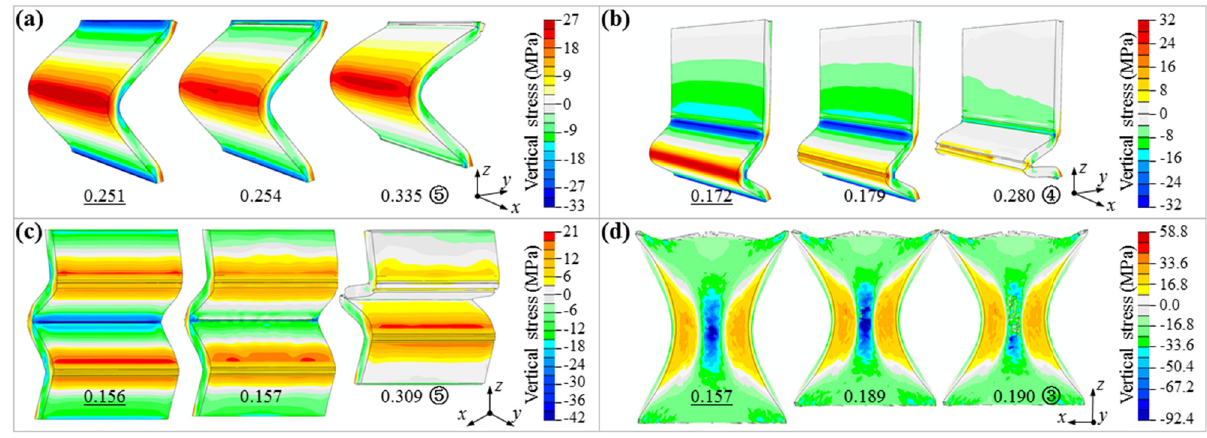
Figure 12: Vertical stress fi eld of spoke No. 1 of ( a ) Tweel; ( b ) Tweel - 2; ( c ) honeycomb; and ( d ) saddle tire samples. The underlined values represent the nominal strain at the moment before failure.